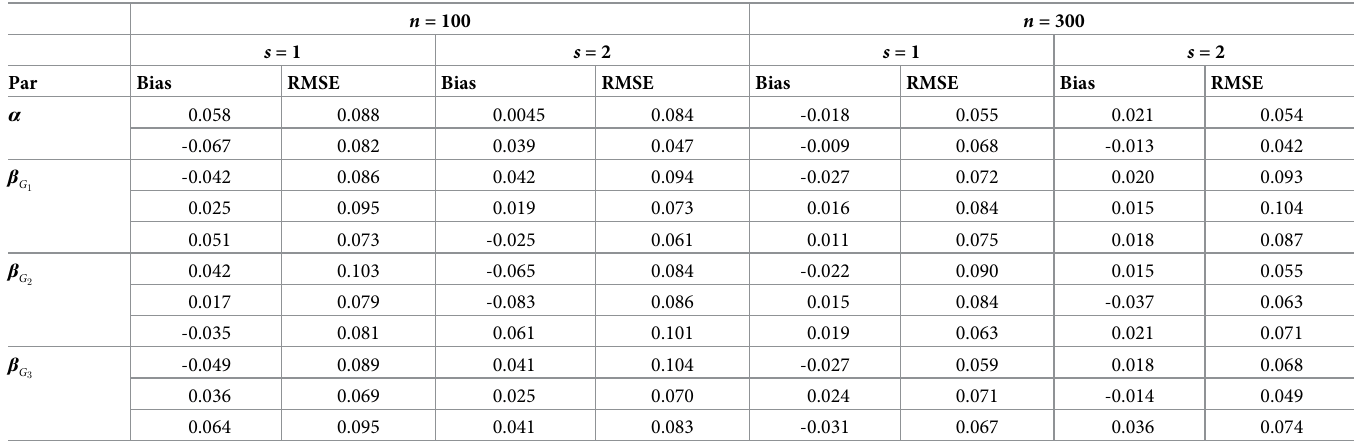
Table 4. Estimate results under prior II.